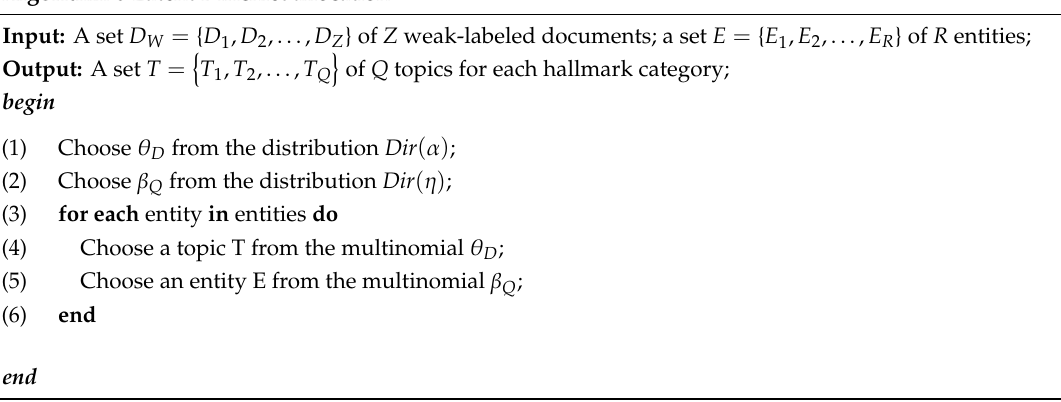
Algorithm 6 Latent Dirichlet